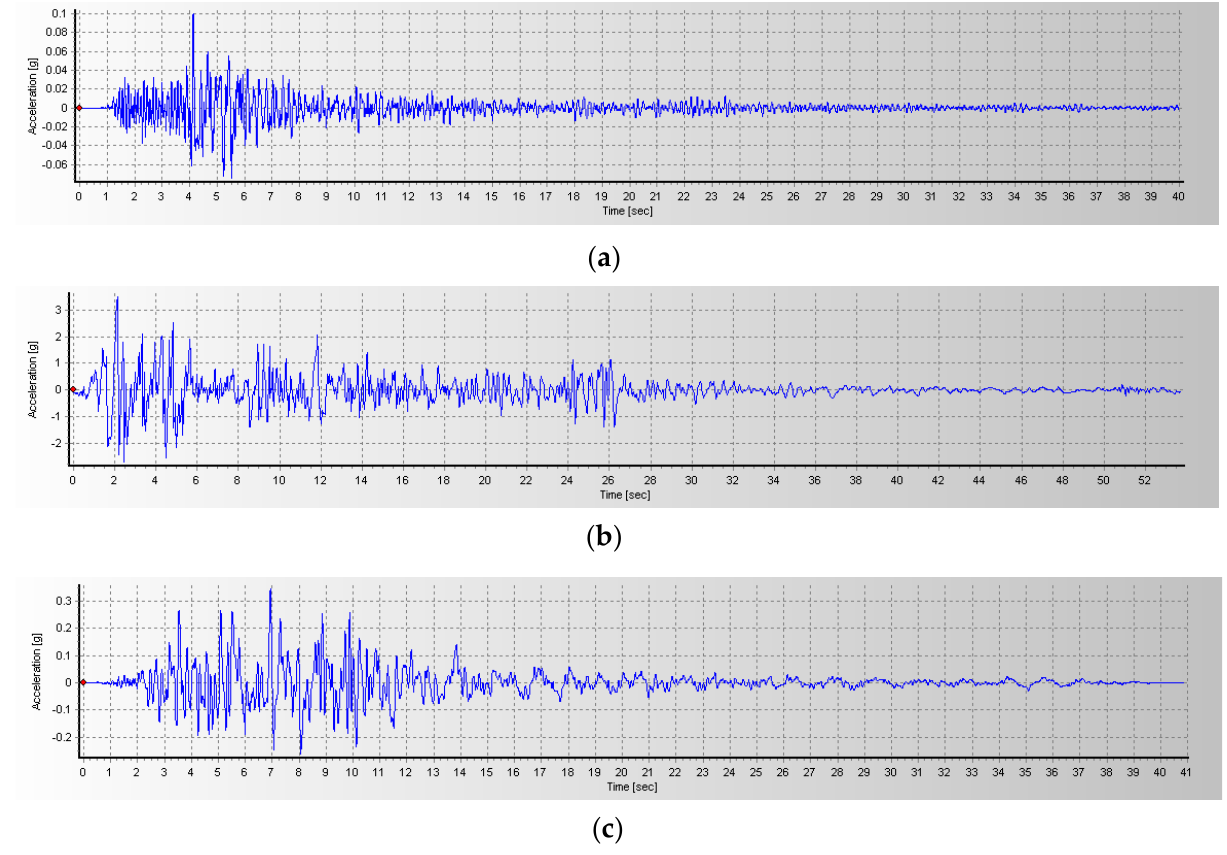
Figure 5. Horizontal component waveform of ( a ) Minxian wave, ( b ) El Centro wave, and ( c ) Kobe wave. Table 5. Loading sequence of three types of input earthquake waves.